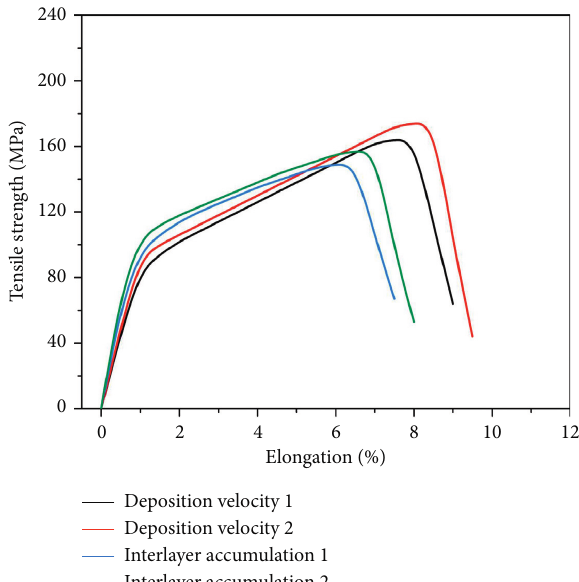
Figure 13: Tensile curves of the deposition wall in the direction of the deposition velocity and interlayer accumulation without the path constraint.